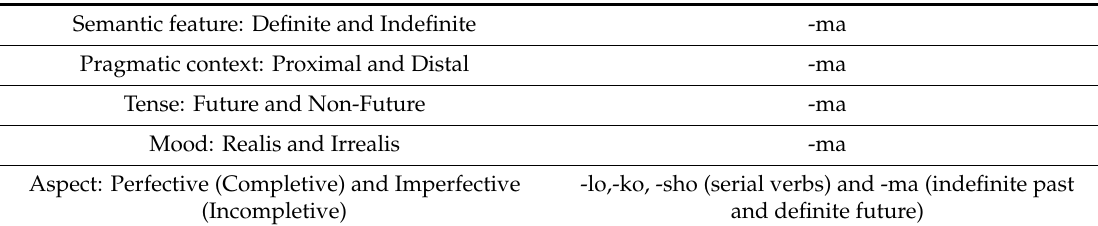
Table 7. Time in